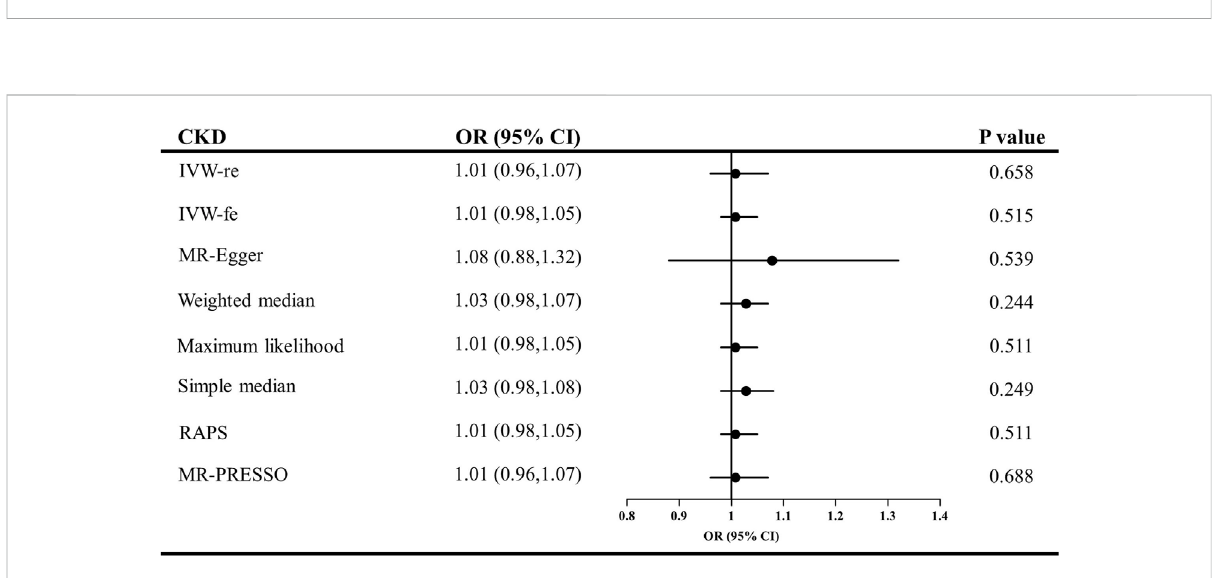
FIGURE 4 Causal estimates of CKD on adiponectin in single-variable MR. OR, odds ratio; CI, con fi dence interval; IVW, Inverse variance weighted method; RAPS, robust adjusted pro fi le score; MR, Mendelian randomization; PRESSO, pleiotropy residual sum and outlier; CKD, chronic kidney